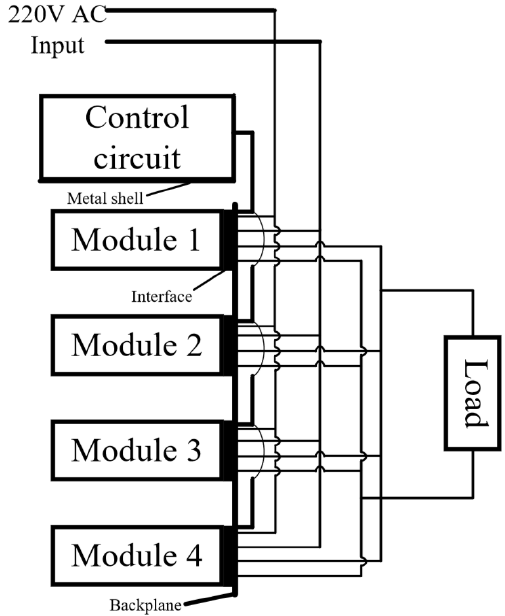
Figure 1. Charging system block